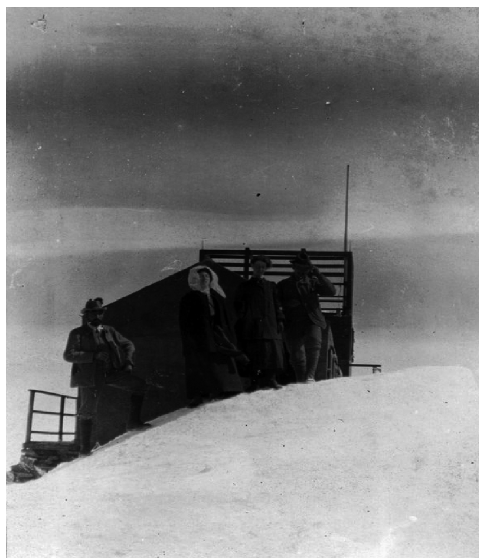
Fig. 6. Queen Margherita’s visit to Capanna